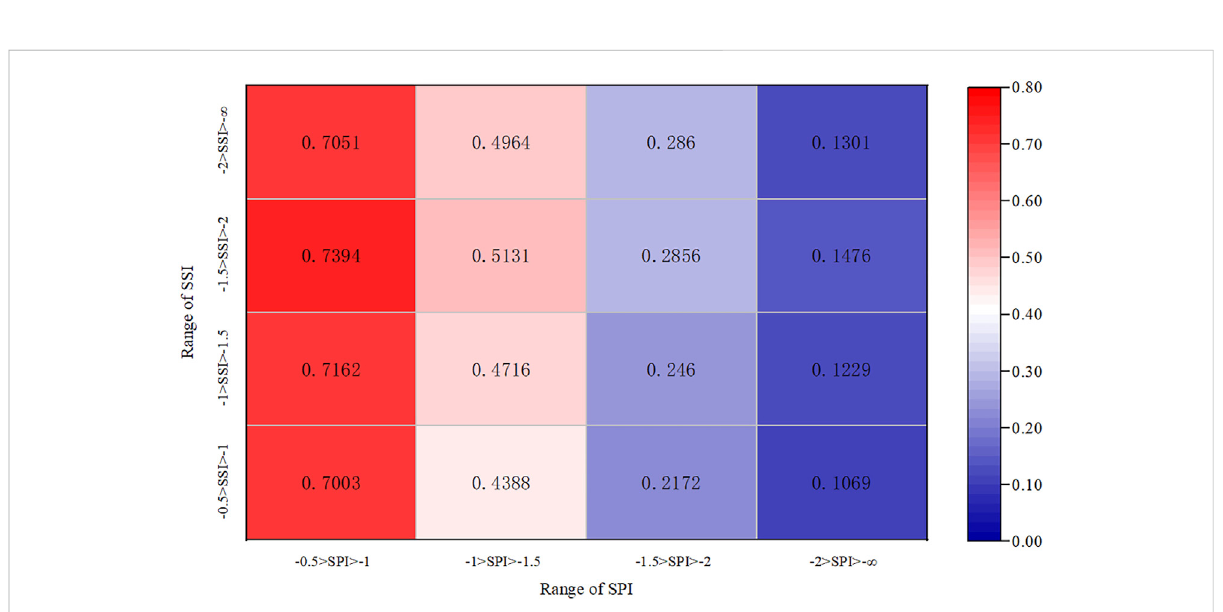
FIGURE 8 Propagation probability of meteorological drought of different grades to hydrological